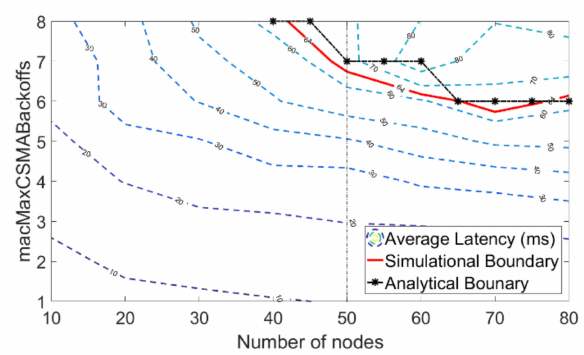
Figure 8. Contour plot for average transmission latency versus network scale and macMinBE given PI = 200 slots.